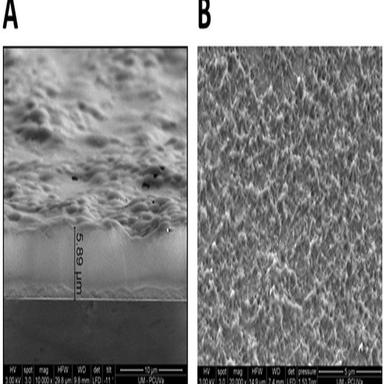
SEM images of REDV-ELR cross-linked films used in cellular "in vitro" studies: cross-sectional (A) and surface (B) views. Scale bars: 10 μm (A) and 5 μm (B).